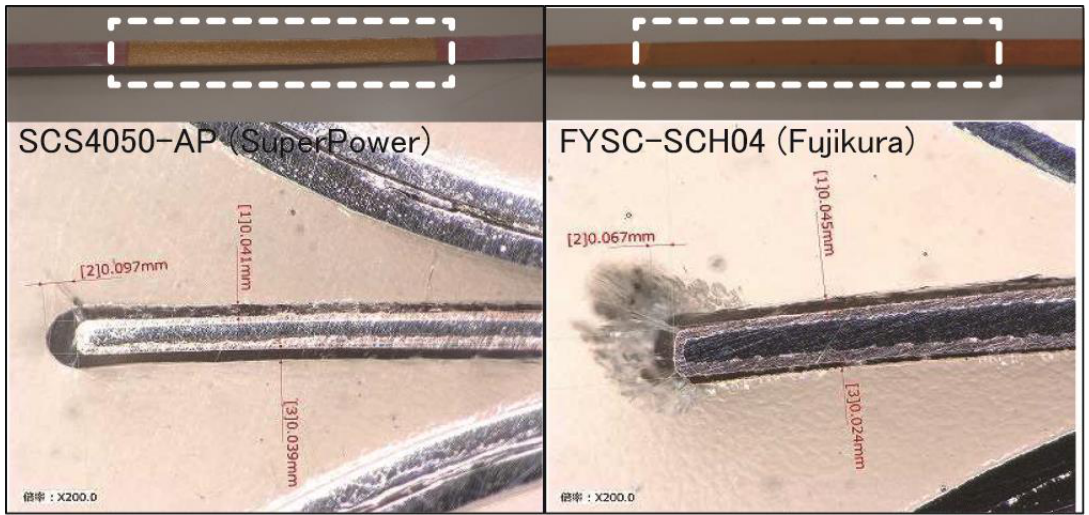
Figure 4. ReBCO tape short sample with inorganic insulation.